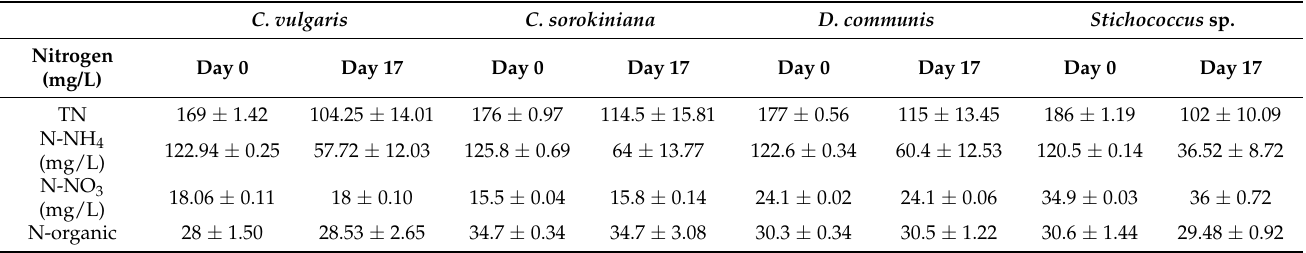
Table 3. Consumption of different nitrogen forms of the four microalgae species cultures in 3.7%